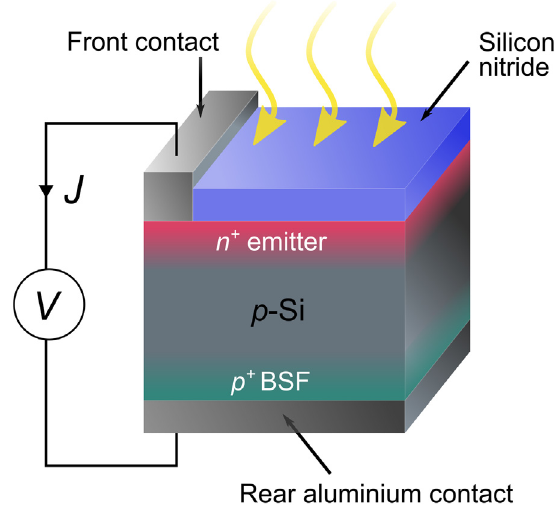
Fig. 2. Schematic of the silicon solar cell considered in this work.